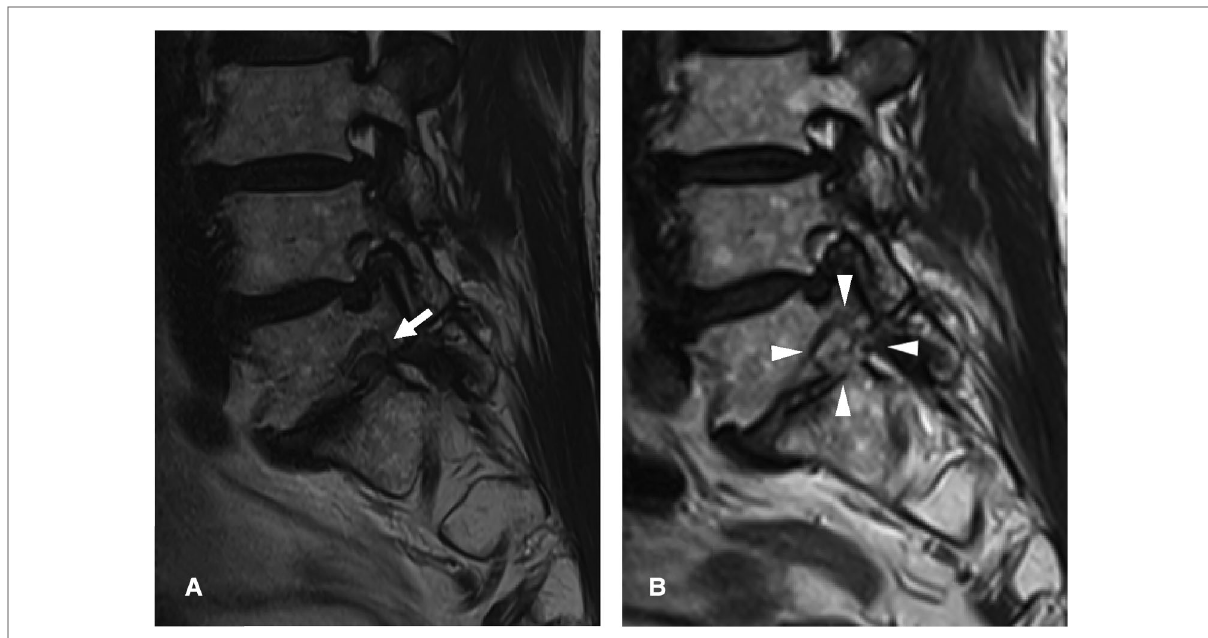
FIGURE 4 An illustrative case of a 75-year-old Male patient. (A) Preoperative magnetic resonance image (MRI) showing foraminal stenosis with spondylolisthesis at the L5-S1 level (arrow). (B) Postoperative MRI showing foraminal decompression with removal of the protruded disc and surrounding bony tissues